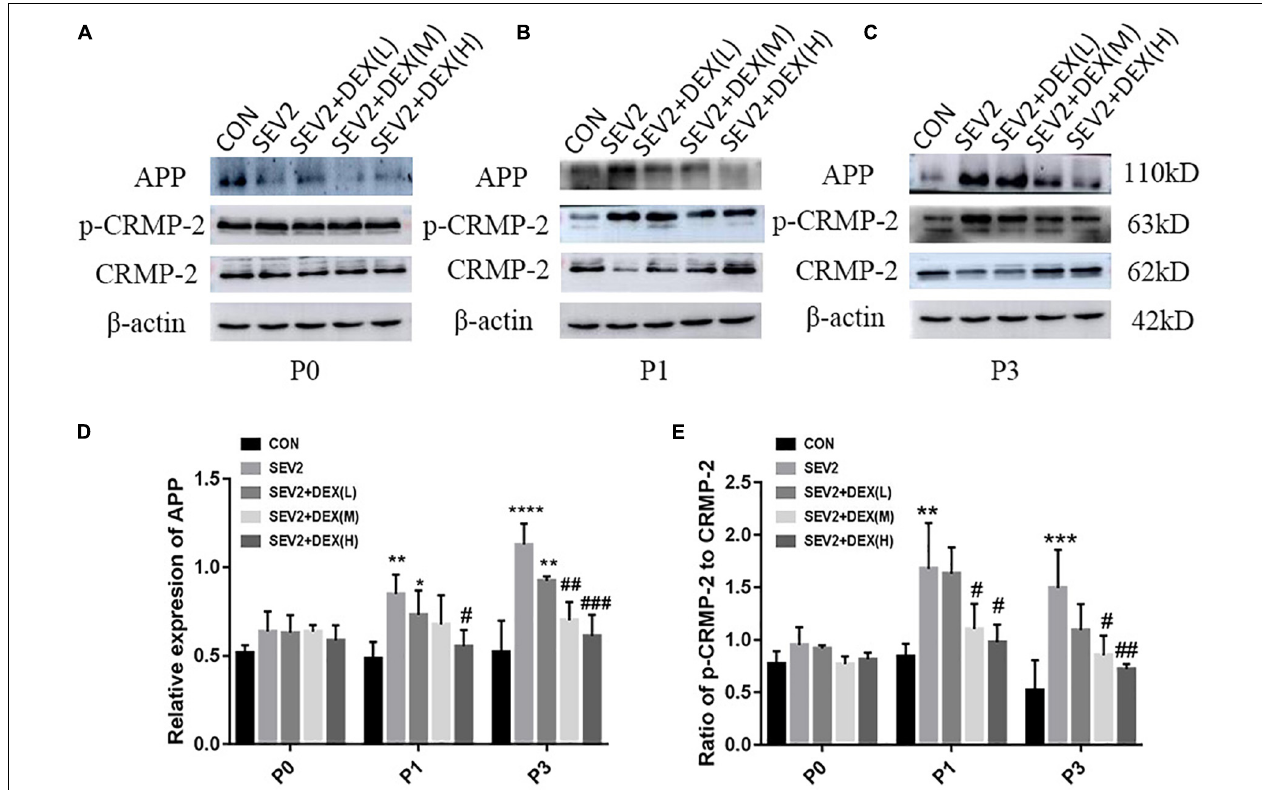
FIGURE 3 | Dex dose-dependently reduced axonal injury by maternal sevoflurane anesthesia in the hippocampus of P1 and P3 rats. Representative Western blots for the expression levels of CRMP-2, p-CRMP-2 and APP of P0 (A) , P1 (B) , and P3 (C) rat hippocampus. Quantification of APP (D) normalized to β -actin and p-CRMP-2/CRMP-2 (E) . Data are expressed as the mean ± SEM ( n = 6 in each group). Comparisons were made using one-way ANOVA and post hoc Tukey’s correction. ∗ P < 0.05, ∗∗ P < 0.01, ∗∗∗ P < 0.001, ∗∗∗∗ P < 0.0001, compared to the CON group; # P < 0.05, ## P < 0.01, ### P < 0.001, compared to the SEV2